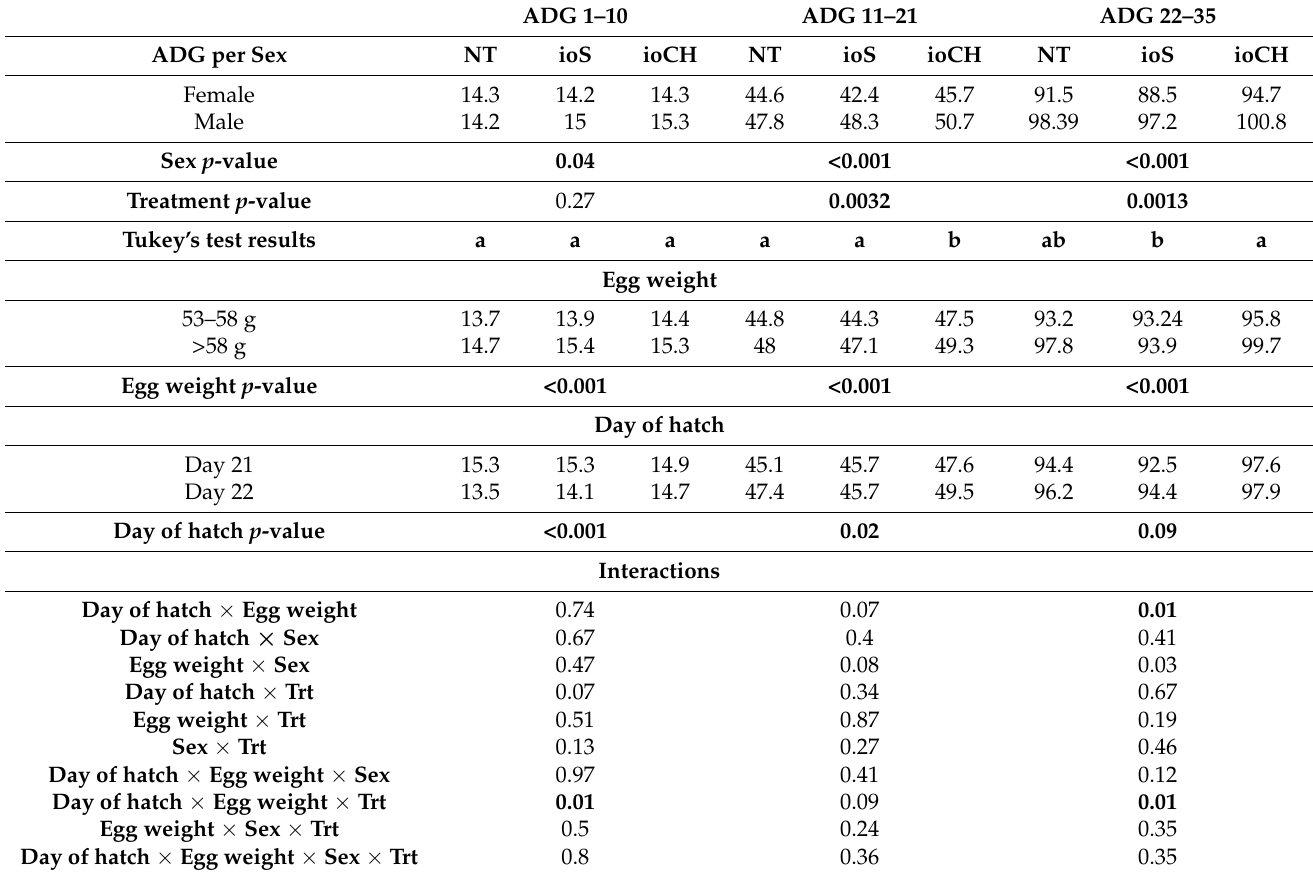
Table 5. Effects of in ovo treatments on sex, egg weight, and day of hatch to average daily